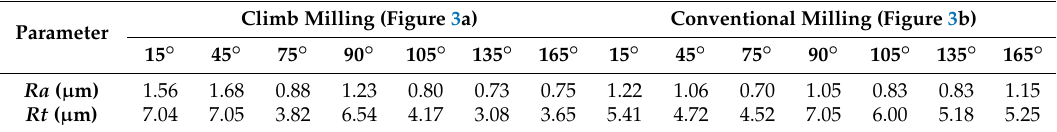
Table 3. Ra and Rt values using climb milling (Figure 3a) and conventional milling (Figure 3b) for experiment 16 in different angular